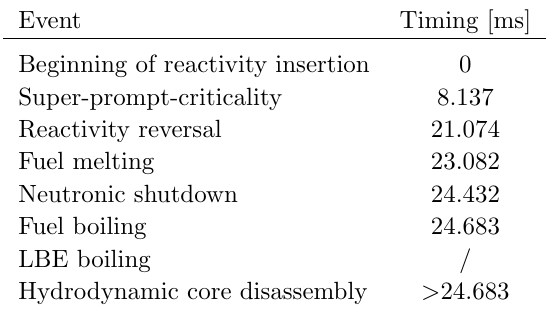
Table 1. Initial conditions of degraded reactor core as employed in simulation of HCDA in MYRRHA. This sim- ulation is performed by employing HCDA Solver.